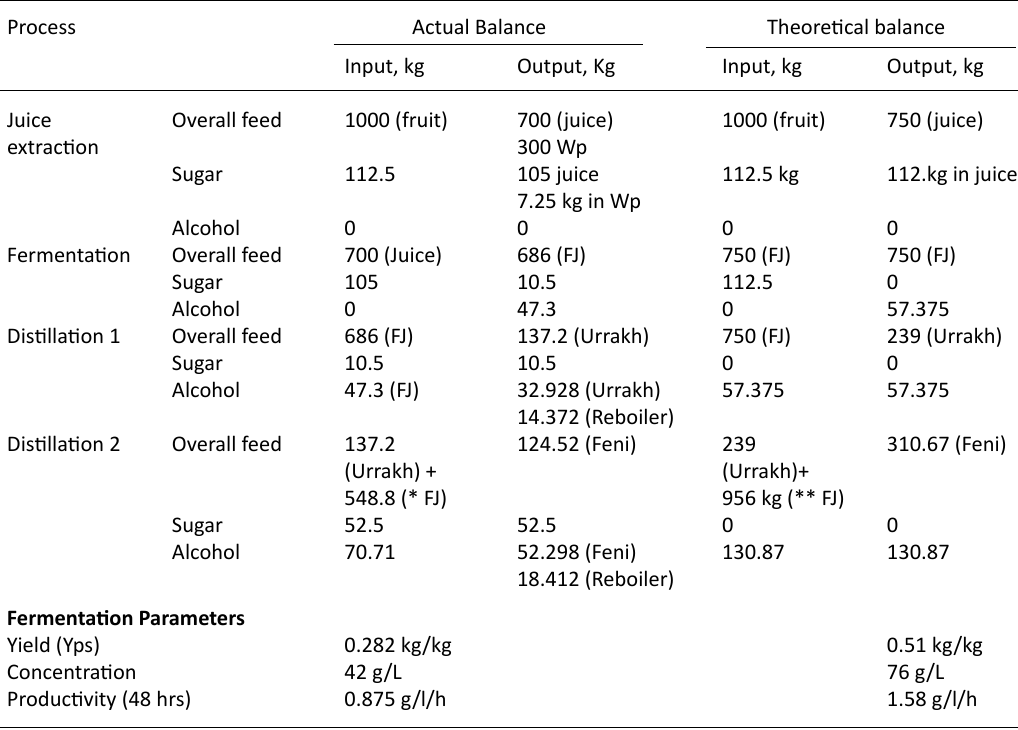
Table 3. Actual and theoretical mass balance of Feni production Process Actual Balance